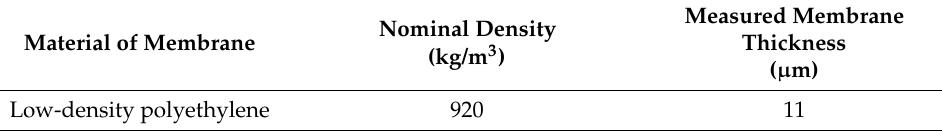
Table 2. Specifications of orifice plate.